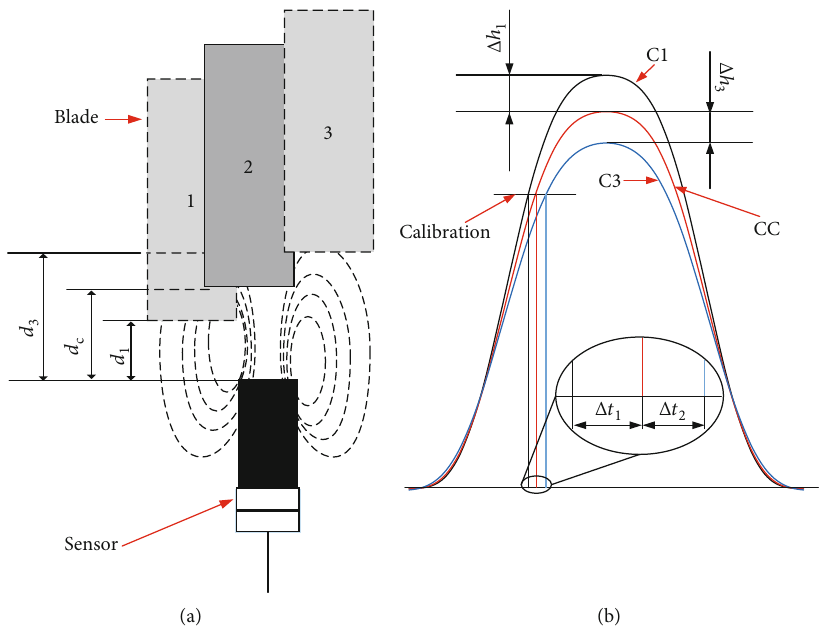
Figure 3: Measuring error introduced by tip clearance variation.